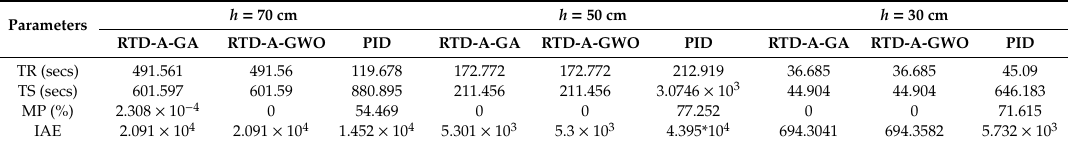
Table 10. Performance comparison of RTD-A and PID for the conical